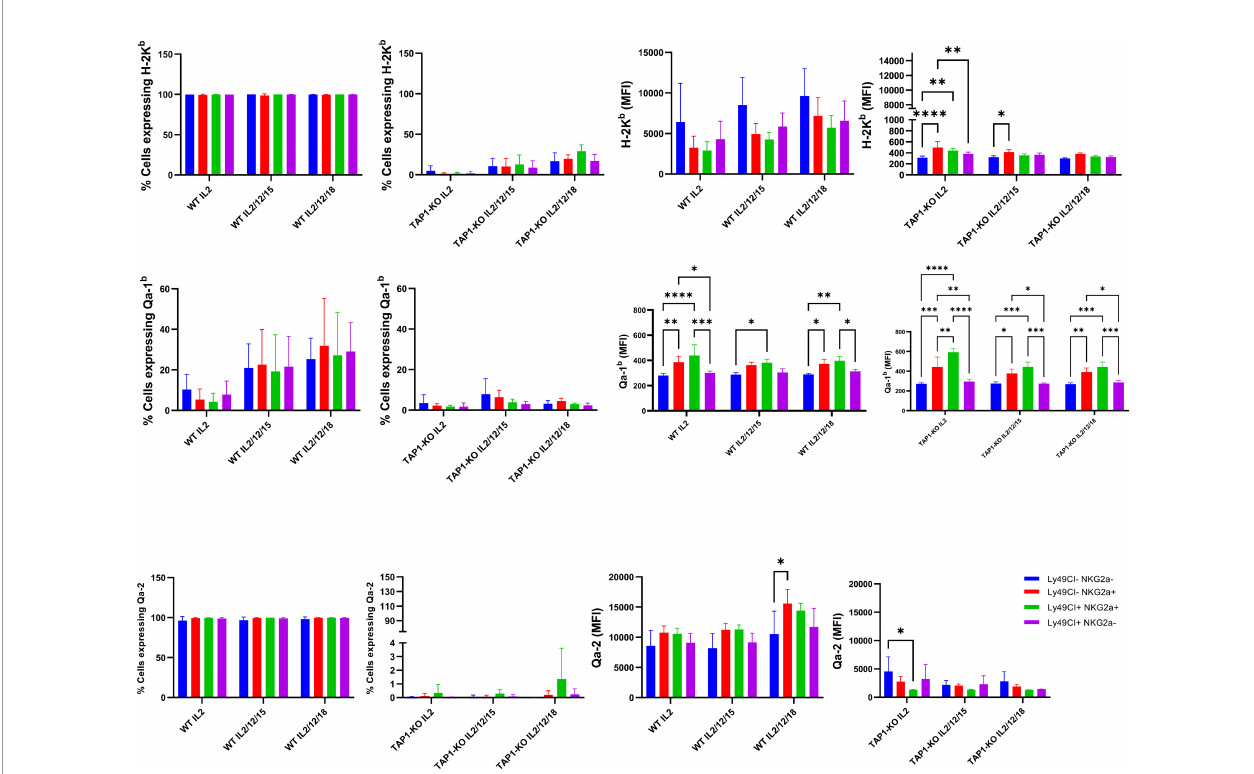
FIGURE 4 | Comparison of MHC class I molecules H-2K b , Qa-2 and Qa-1 b in NK cells derived from spleens of the B6 and TAP-KO strains. The NK cells were expanded for 18 hours in the presence of IL-2 and stimulated with (IL-2, IL-12, IL-15) or (IL-2, IL-12, IL-18) with an IL-2 only control group as well. The expression levels were checked in the NK cell subsets de fi ned by the presence or absence of NKG2A and Ly49C/I. Statistical analysis was performed using GraphPad Prism 9.0.0 with an ordinary two-way ANOVA with Tukey ’ s multiple comparisons tests (n=3). *, p<0.05, **, p<0.01, ***, p<0.001 and ****,